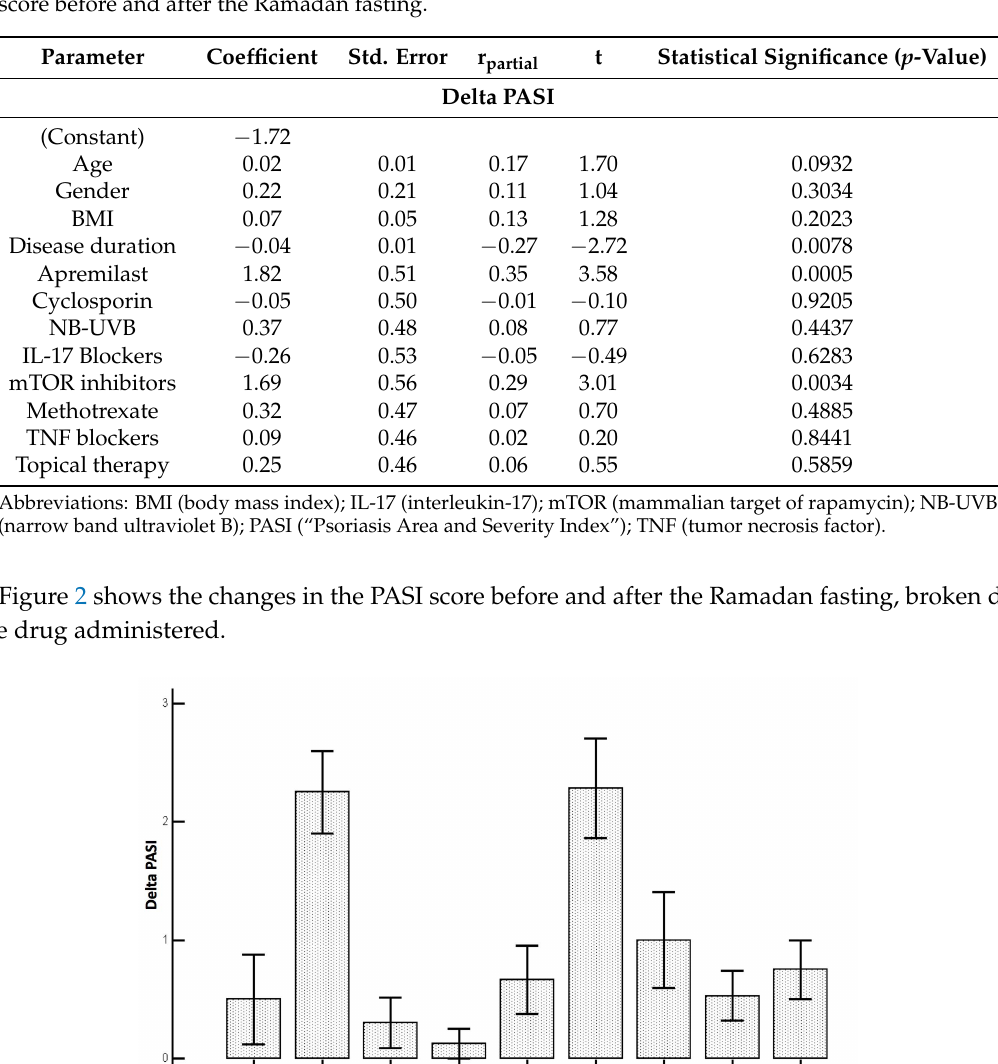
Table 3. Multivariate analysis of the determinants of change in the “Psoriasis Area and Severity” (PASI) score before and after the Ramadan fasting.